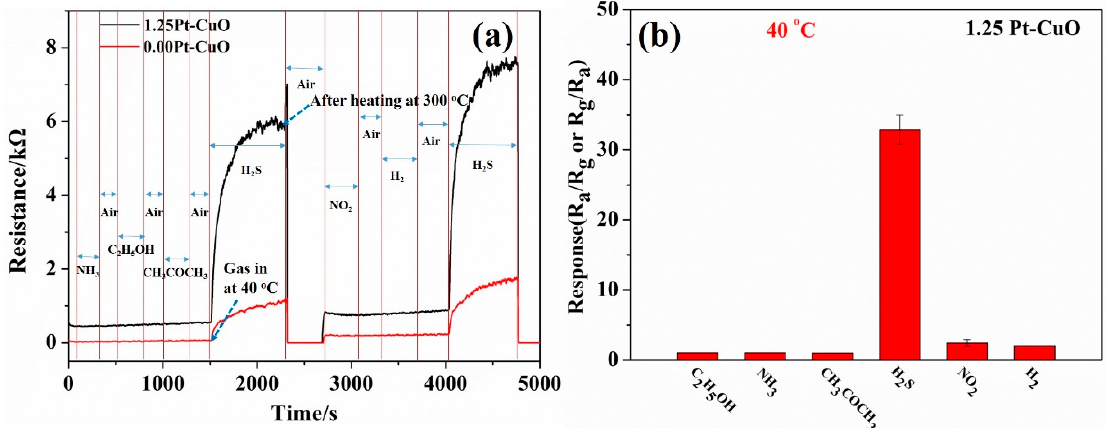
Figure 10. ( a ) Dynamic response curves of 1.25Pt-CuO and 0.00Pt-CuO based sensor to 1 ppm H 2 S and 50 ppm various interfering gases at 40 °C; ( b ) gas response (R a /R g or R g /R a ) of 1.25Pt-CuO to 50 ppm different gases and 1 ppm H 2 S gas, operated at 40 °C.